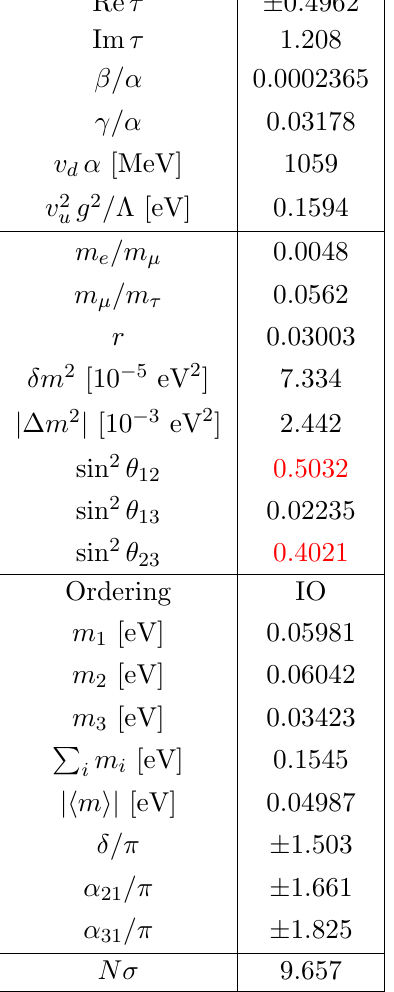
; k (cid:11) ; k (cid:11) ) = (2 ; 4 ; 1 2 3